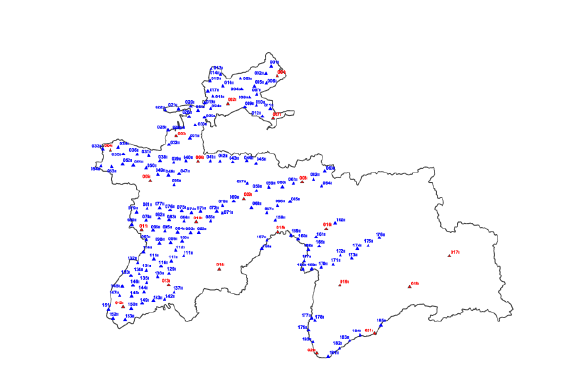
Figure 1. New open and unclassified 1 st class (red color) and 2 nd class (blue) GPS network established under supervision of Dr. V. Kotzev, project expert in Geodesy.